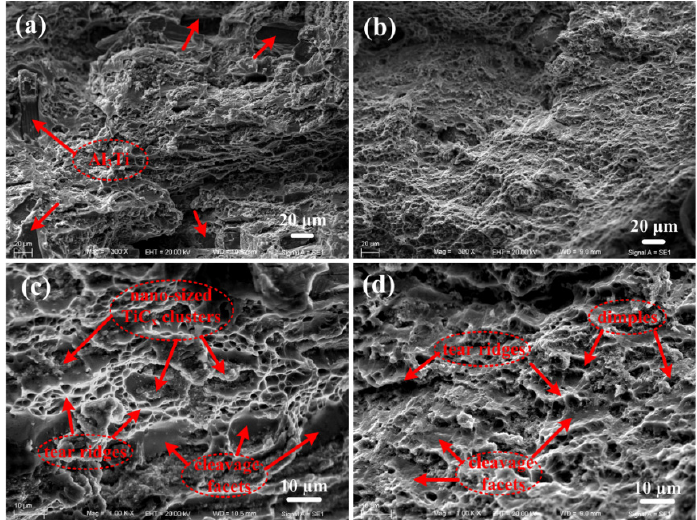
Figure 5. Scanning electron microscope (SEM) images of the tensile fracture surface of 9 vol% nano-sized TiC x /2009Al composite fabricated by using ( a ) untreated CNTs; ( b ) CNTs milled for 2 h as carbon source; ( c ) and ( d ) are the high magnified images of the corresponding composites.